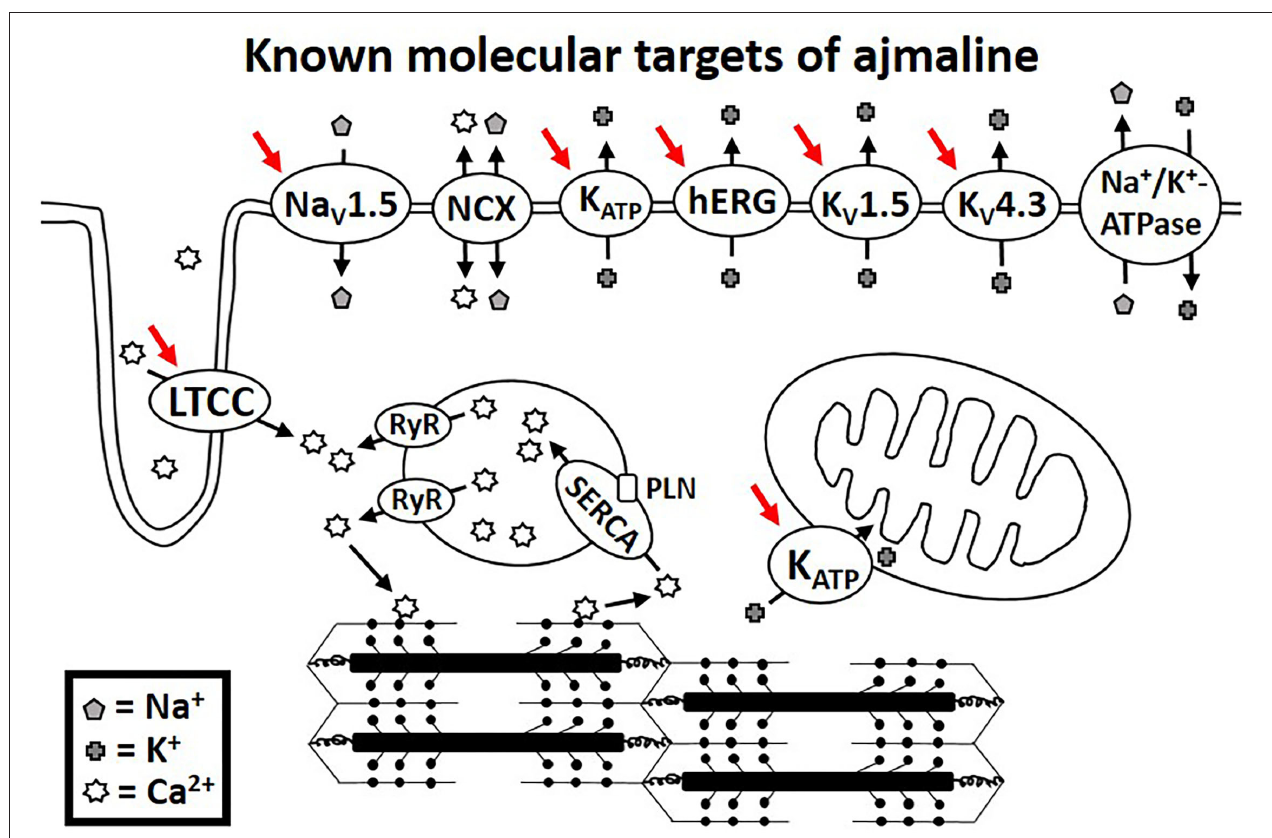
FIGURE 1 | Molecular targets of ajmaline as suggested by functional studies indicated by red arrows.